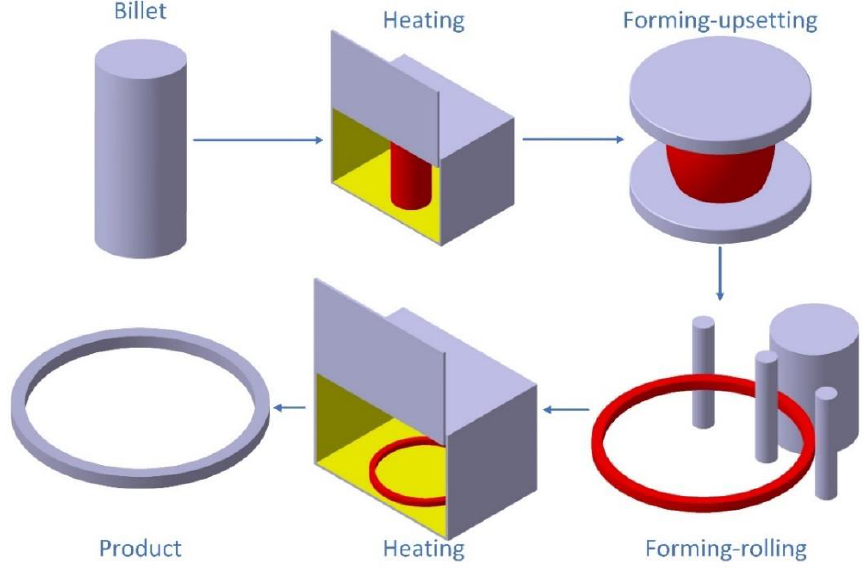
Figure 1. Schematic diagram of ring forging production process.